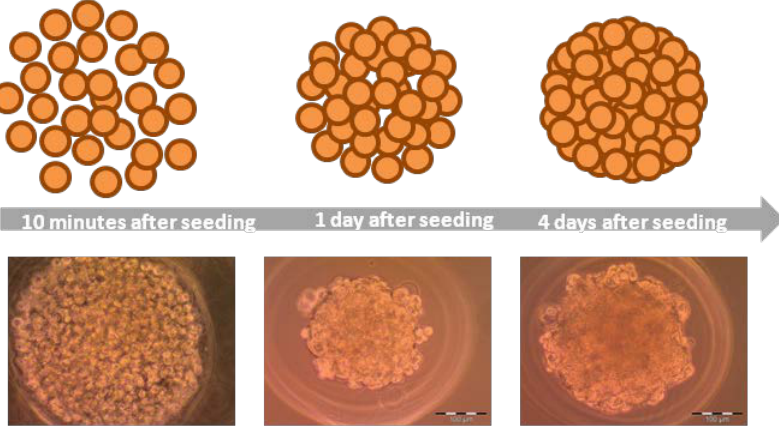
Figure 1. Formation of spheroids on MCF-7 cell line.